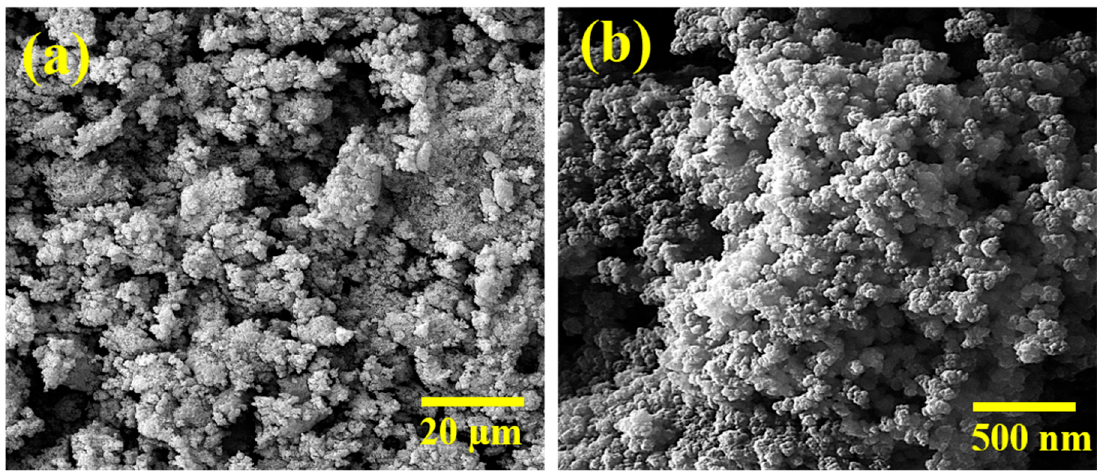
Figure 5. SEM images of synthesized PPy nanoparticles ( a , b ) in different magnification.